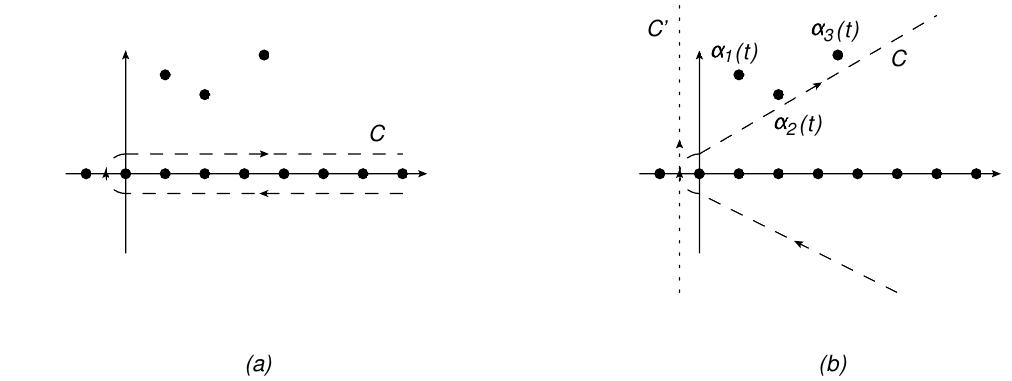
Figure 6: (a) Pole structure of the integrand in eq. (72), where poles in the real axis arise from zeroes of the sin function; (b) Deformation of the original integration contour C (enclosing the real axis) to make a vertical contour C (cid:48) , which is closed at